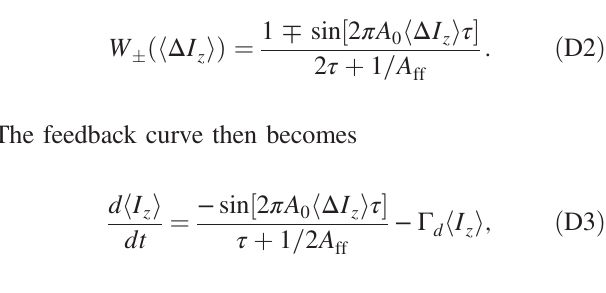
FIG. 11. FIDs for QD2. Triangles, squares, and circles are the FID envelopes resulting from a nuclear-spin ensemble at thermal equilibrium, after state-of-the art purification [37], and after our optimal purification, respectively. Fitting these data with the blue, purple, and orange C ð τ curves yields T (cid:4) 2 ¼ 3 . 3 ð 3 Þ ns, probe Þ α ¼ 1 . 9 ð 4 Þ ; T (cid:4) 64 ð 3 Þ ns, α ¼ 2 . 0 ð 2 Þ ; and T (cid:4) 296 ð 5 Þ ns, 2 ¼ 2 ¼ α ¼ 1 . 65 ð 8 Þ ,